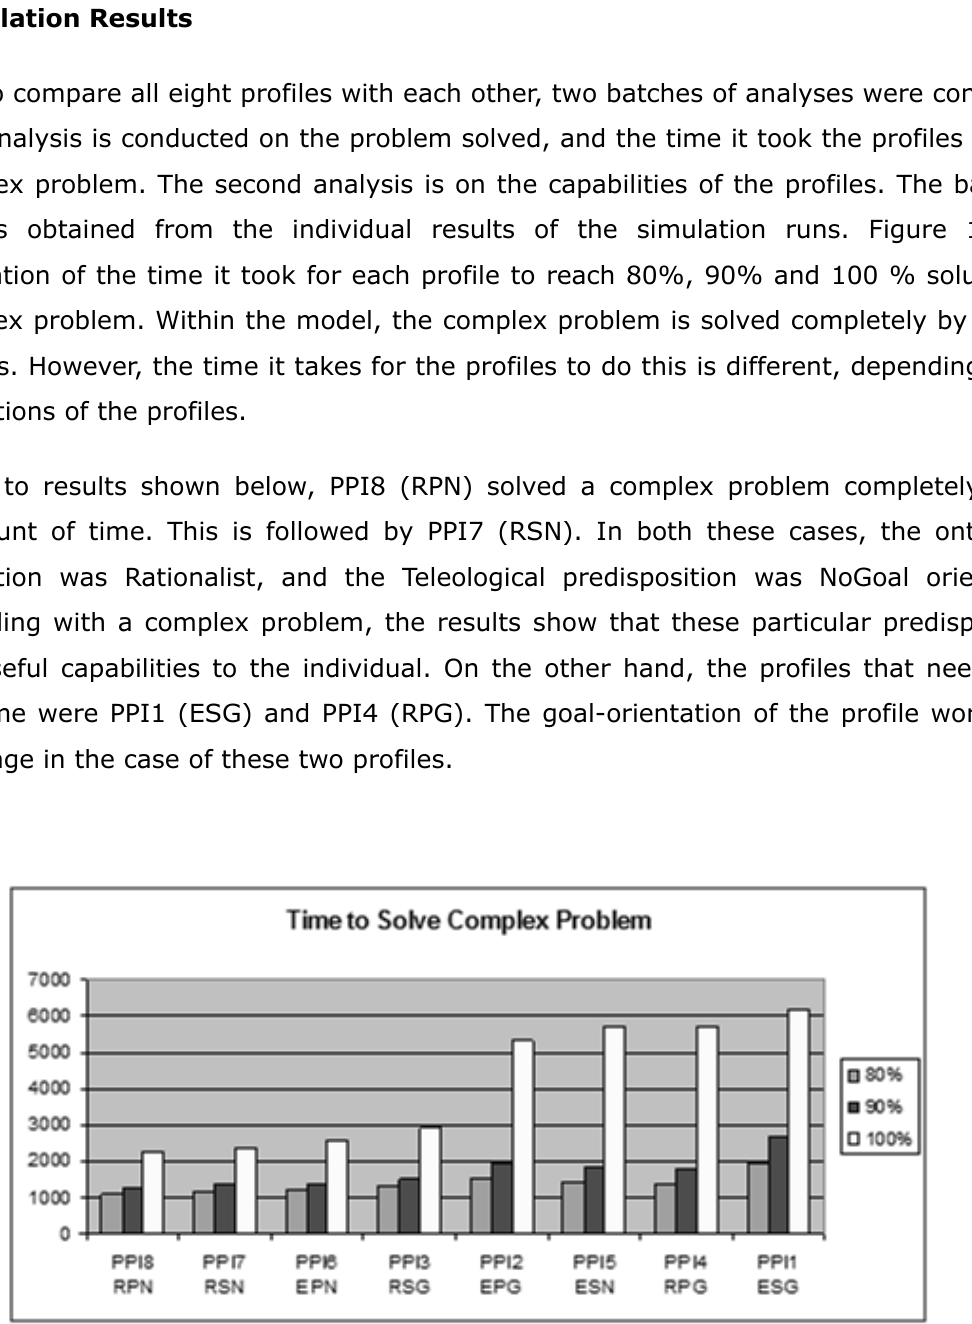
Figure 11. Comparison of Profiles for Complex Problem